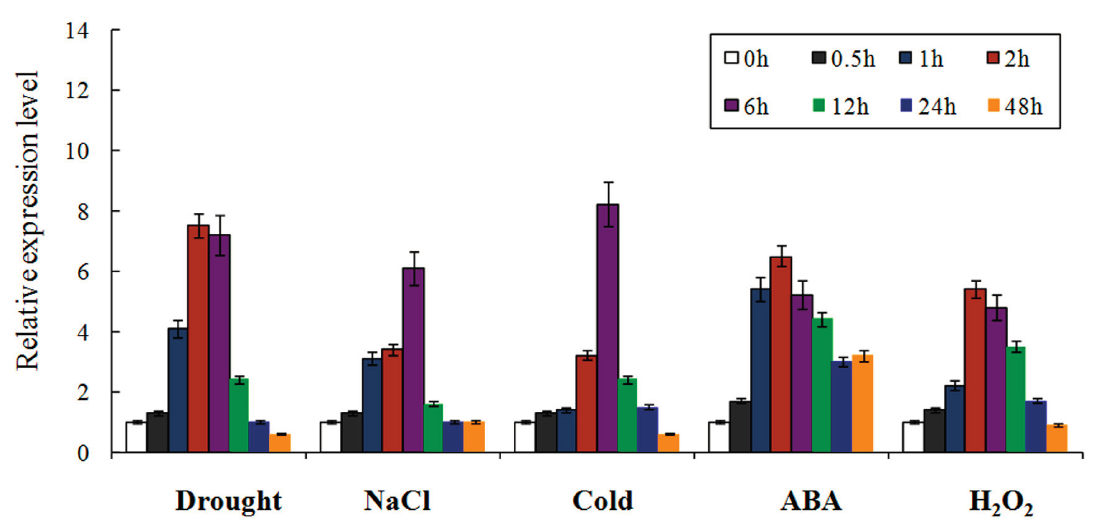
Figure 3. Expression of W36 under treatments of ABA, drought, salt, H 2 O 2 , and cold. The expression of W36 under different stimuli was normalized to the expression of wheat β -actin . Means and SD were calculated from three independent experiments.